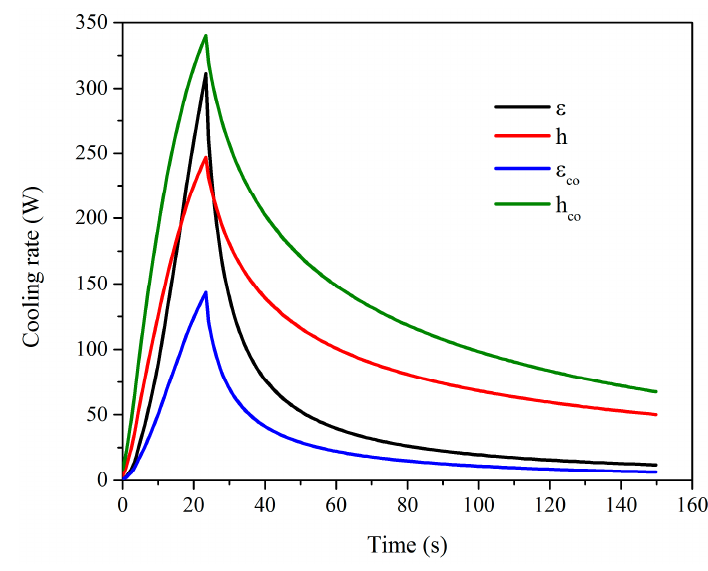
Figure 7. Cooling rate by free convection and radiation for t+ = 2 ms.